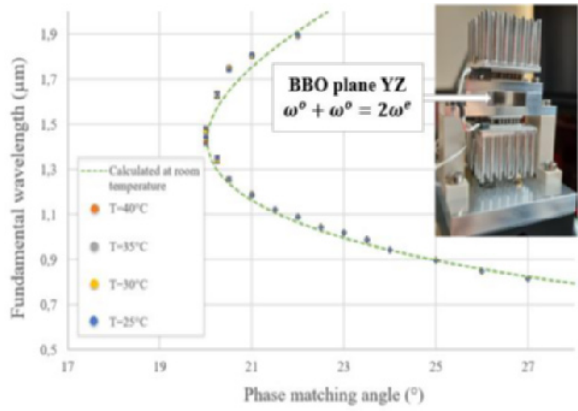
Fig. 2. BBO Type I SHG phase-matching curve for 4 different temperatures in the YZ plane.